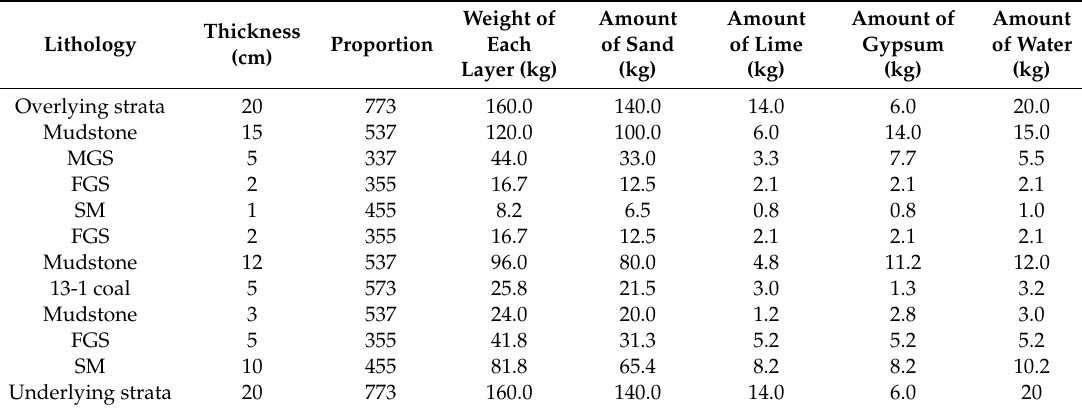
Table 2. Strata thicknesses and proportions in the physical